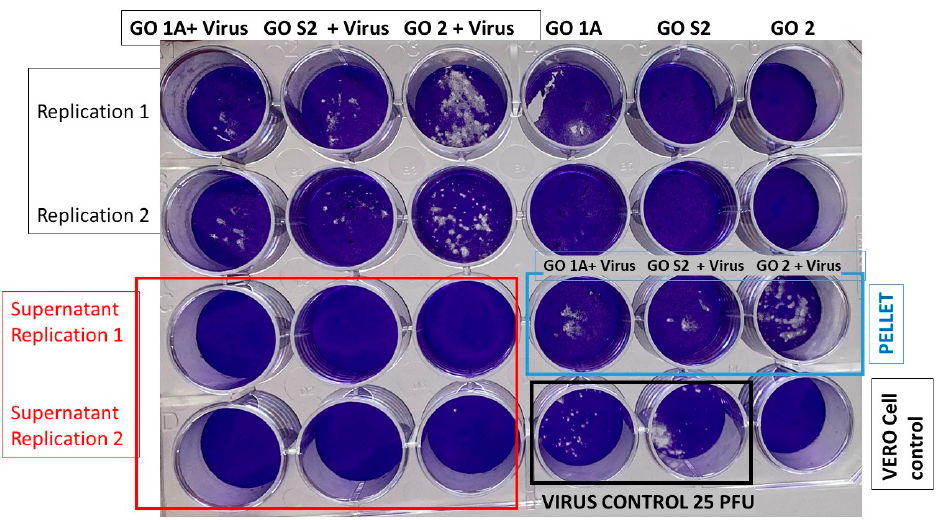
Figure 6. SARS-CoV-2 virus plating assay in VERO cells at concentrations of 400 µg/mL of centrifuged and non-centrifuged OG alongside the OG + virus mixture at a centrifugation speed of 13,000 rpm.